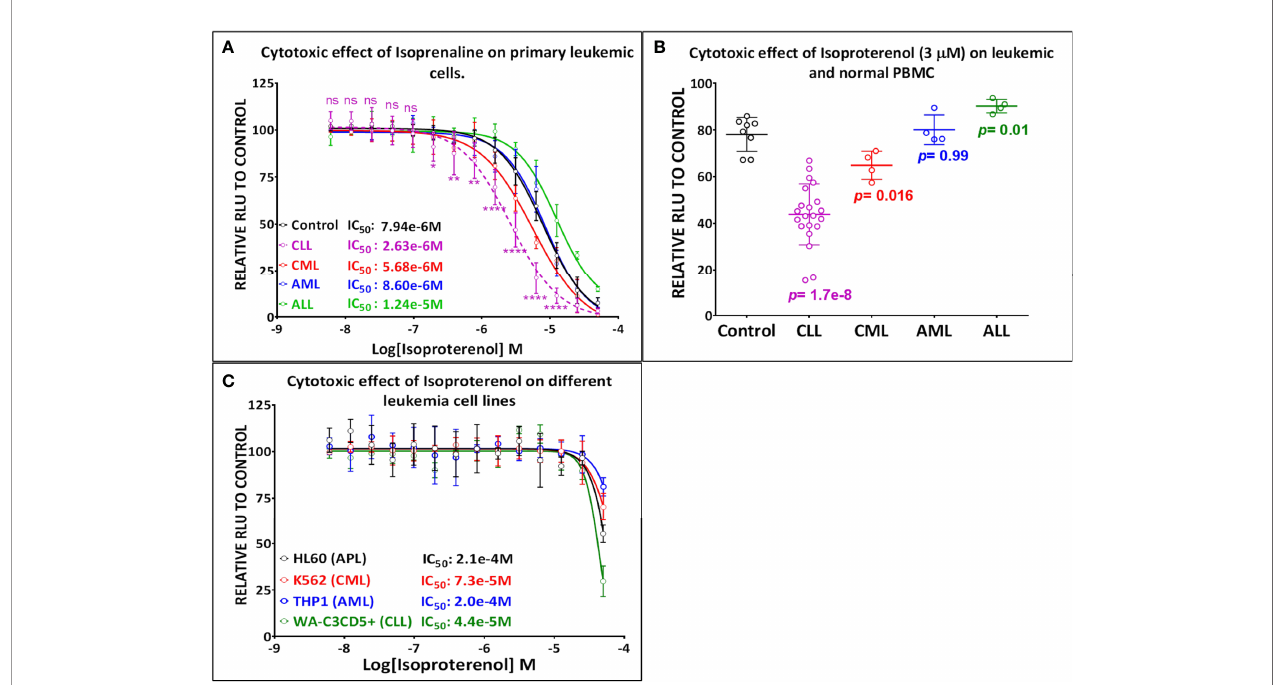
FIGURE 2 | Primary leukemic cells deriving from CLL patients show the highest sensitivity to Isoprenaline. (A) Dose-response plots showing the cytotoxic effect of Isoprenaline on PBMC isolated from healthy donors (solid line) and leukemic patients (dashed line). Each dose-response curve represents the average of multiple samples testing; data are expressed as mean±SD and normalized to DMSO (100%). Cell viability was determined by the CellTiter-Glo luminescence-based assay. CPCs are the only leukemic cells to show a signi fi cant higher sensitivity to Isoprenaline than the normal PBMCs. The p-values for each point (Isoprenaline concentration) of the plot were calculated with Student ’ s t test (ns, non-signi fi cant (P>0.05); *P < 0.05; **P < 0.01 and ****P < 0.0001). (B) The cytotoxic effect of a single dose (3µM) of Isoprenaline is compared for PBMC (n=8) and the four leukemia subtypes respectively [CLL (n= 23), CML (n=4), AML (n= 4), ALL (n=4)] (p values are indicated for each group). (C) Dose-dependent cytotoxic effect of Isoprenaline on different Leukemia cell